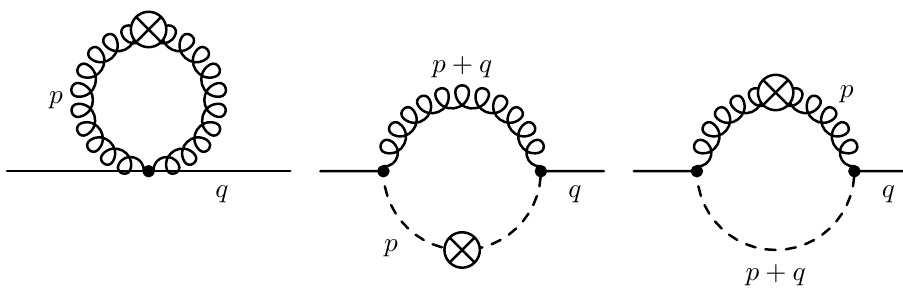
Figure 1 . Feynman diagrams encoding the scalar contributions to the beta functions. The solid line denotes the background scalar (cid:12)eld (cid:22) (cid:30) , the dashed line denotes the (cid:13)uctuating scalar (cid:12)eld ^ (cid:30) , the curly line the graviton propagator. The crossed circle denotes the insertion of the cuto(cid:11) operator @ t R k